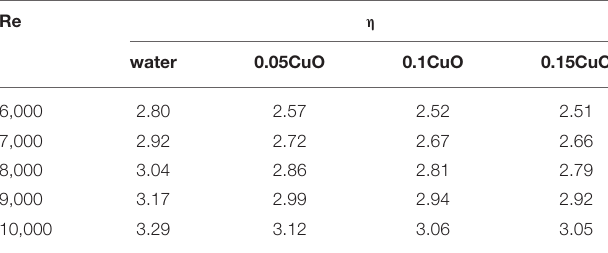
TABLE 3 | Comprehensive evaluation factors of fluid in flat tube and circular tube at different Reynolds number and concentration. Re η water 0.05CuO 0.1CuO